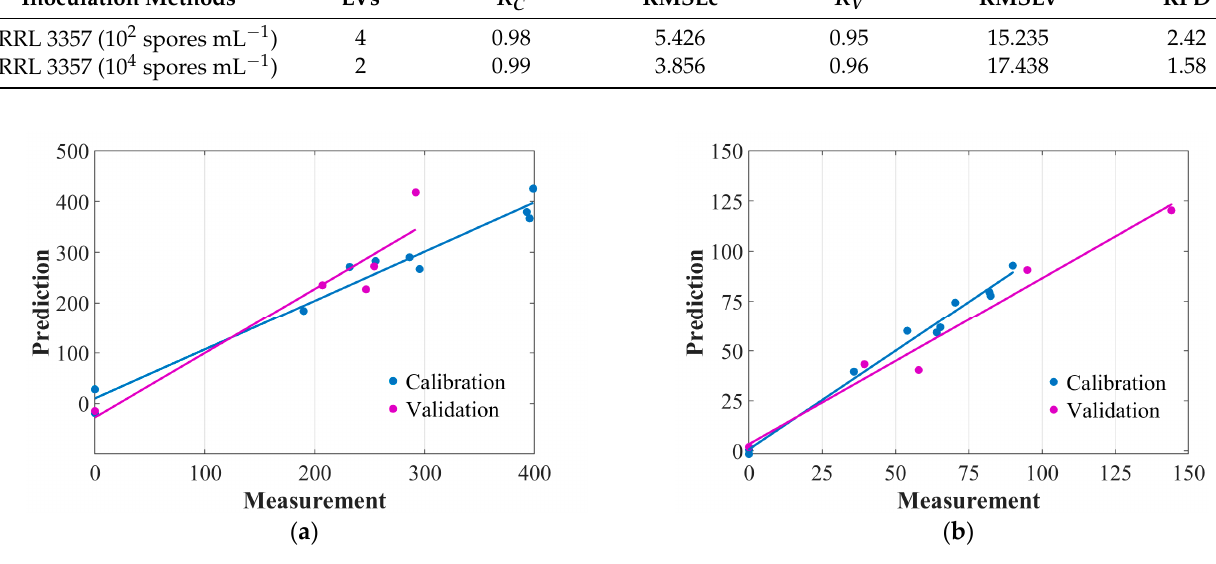
A prediction image, similar to a heat map, was used as a visualization tool to observe the variation of content in the spatial dimension, with each pixel quantitatively displaying the level of AFB 1 content with different colors. The prediction images for different culture durations and inoculation types are shown in Figure 7. The color from cold to warm indicates the concentration value of AFB 1 from low to high.